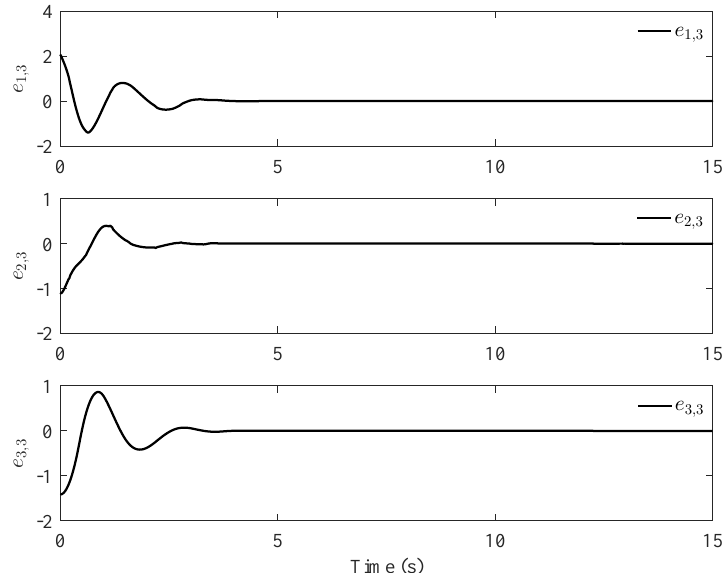
Figure 5. The tracking errors of the attitude subsystem.